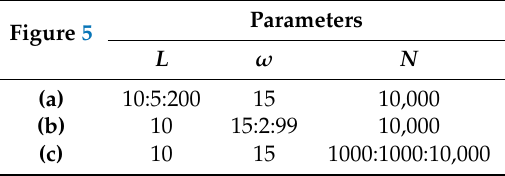
Table 3. Configuration of The